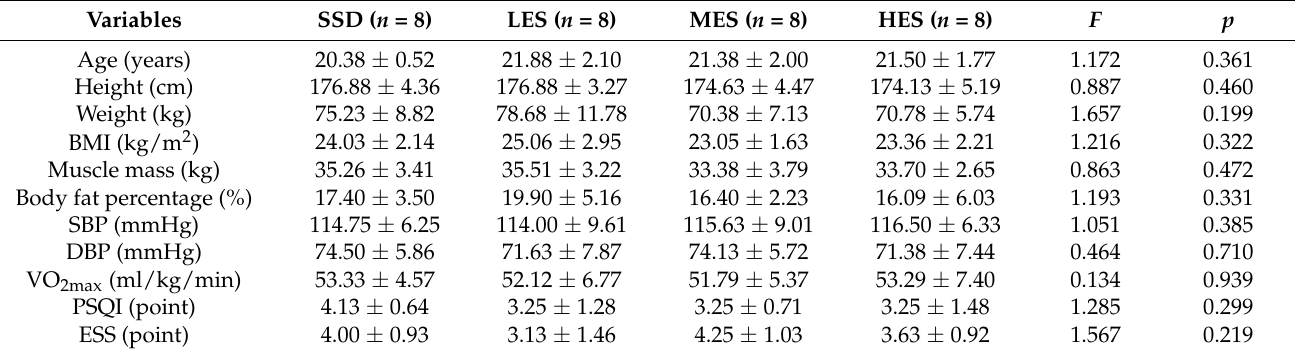
Table 1. Characteristics of the participants according to groups and results of